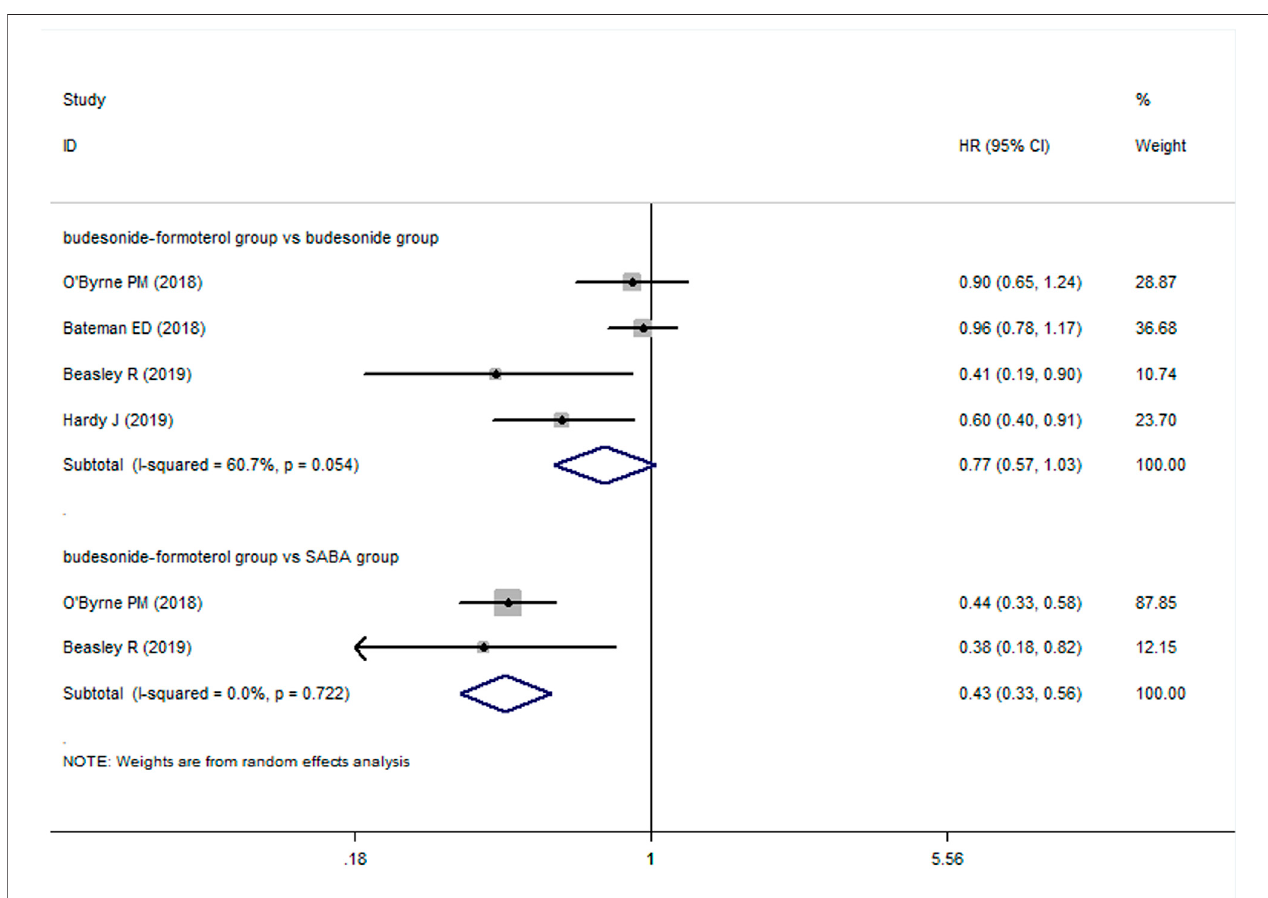
FIGURE 3 | Comparison of the difference of time to fi rst severe exacerbation in the three treatment groups.